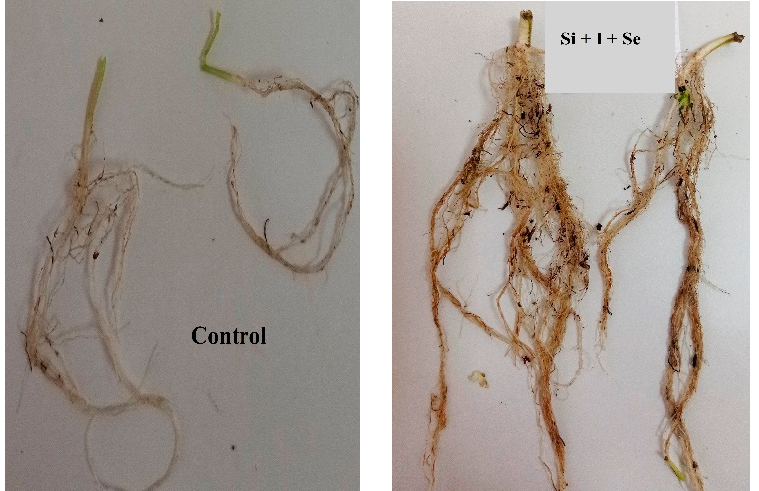
Figure 1. Root system of chervil under I, Se and Si treatments as compared to control.